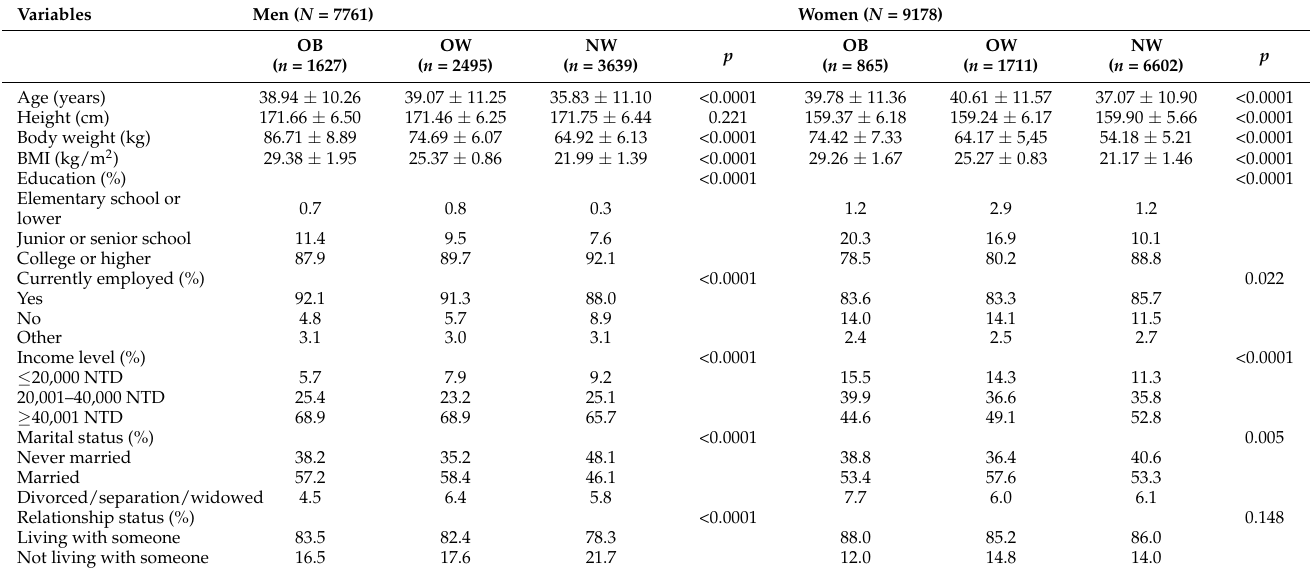
Table 1. Demographic characteristics of the study participants according to obesity status among adults in